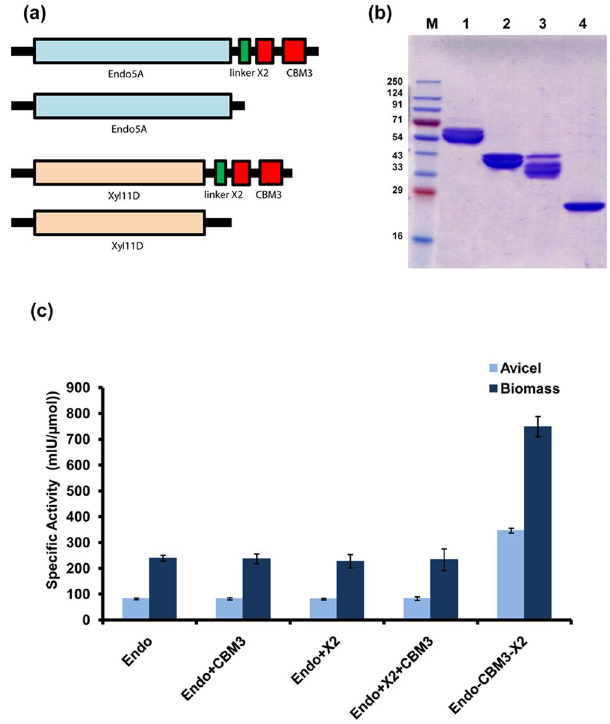
Figure 6. The impact of X2-CBM3 on the activity of endoglucanase (Endo5A) and xylanase (Xyl11D). ( a ) Domain organization of fusion construct containing Endo5A and Xyl11D along with X2-CBM3 linked through a Gly-Ser linker, ( b ) SDS-PAGE profile of fusion enzyme Endo5A-X2-CBM3 (Lane1), native endoglucanase Endo5A (Lane 2), fusion enzyme Xyl11D-X2-CBM3 (Lane 3), and native xylanase Xyl11D (Lane 4); M: molecular weight marker in kDa. ( c ) Enzyme activity of endoglucanase for native and fusion constructs measured towards insoluble substrates- Avicel and biomass. Enzyme activity for xylanase was not included as the activity of both of its constructs towards insoluble substrate was negligible (see text and Table 4 for details).